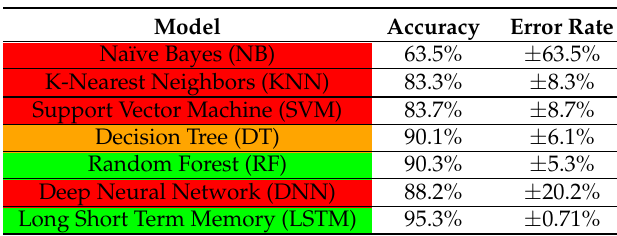
Table 10. Accuracy comparison between different ML